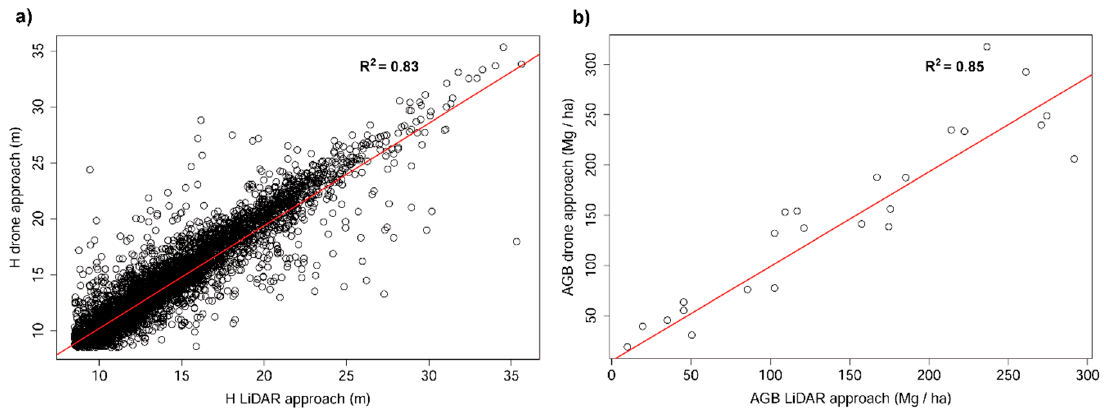
Figure 10. Regression analysis between RGB and LiDAR data: ( a ) H correlation, ( b ) AGB correlation.